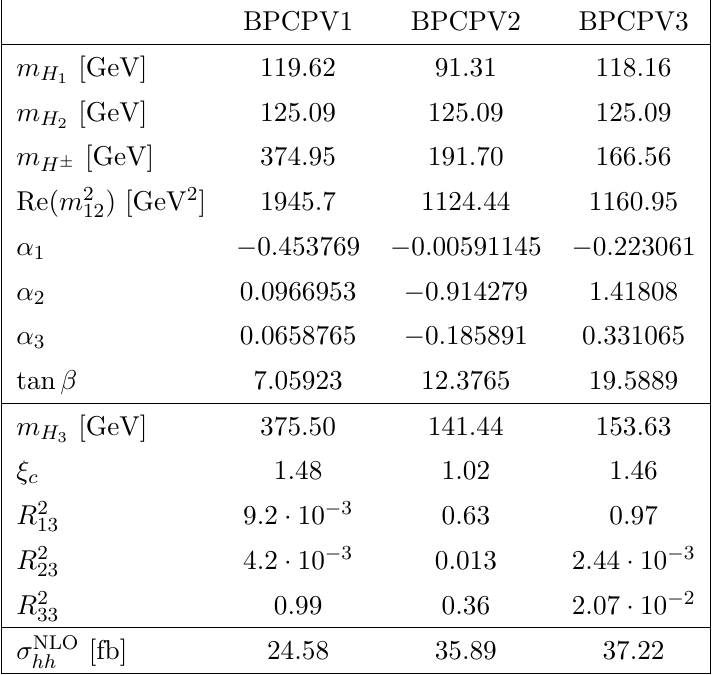
Table 8 . Line 1-8: the input parameters of the type I CP-violating benchmarks with H 2 (cid:17) h and (cid:24) c > 1, compatible with all constraints. Line 9 to 13: the derived 3rd neutral Higgs boson mass, the (cid:24) c value and the CP-odd admixtures R 2 . Line 14: the NLO QCD gluon fusion hh production i 3